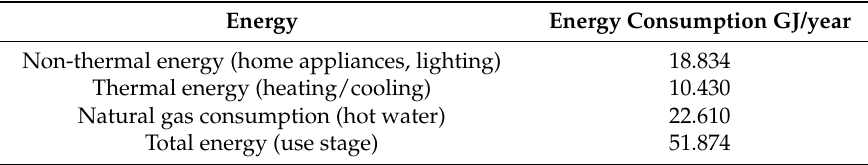
Table A5. Life cycle inventory of energy for the use stage of case study buildings.